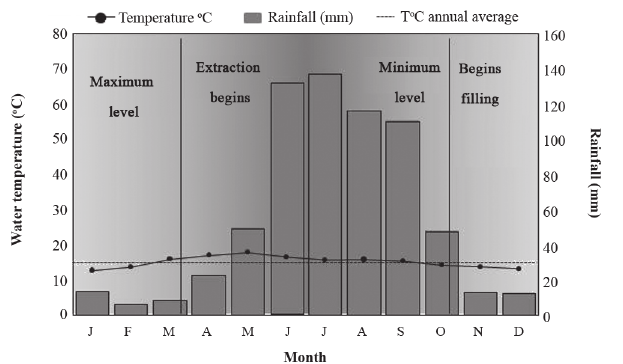
Fig. 3. Catch per unit effort values during a sampling 24 hours.